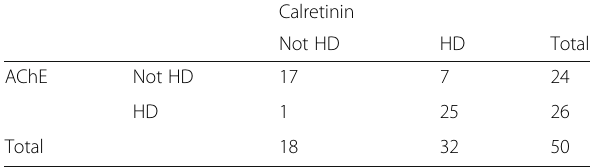
Table 1 Comparison of the diagnosis of HD using the HE vs. AChE (gold standard) assays